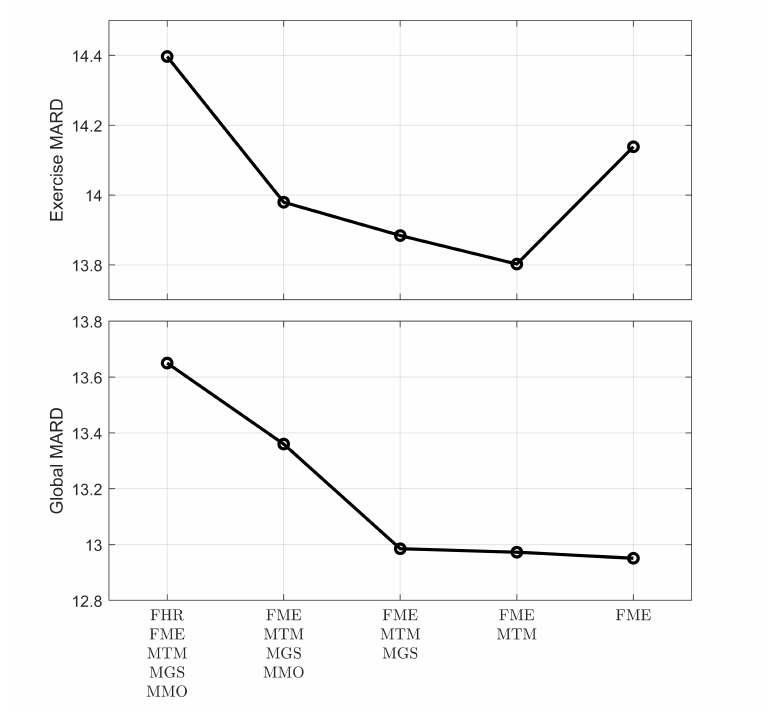
Figure 2. Sequence of MARD values for the exercise period ( top panel ) and for the whole trial ( bottom panel ), as each signal was removed from the